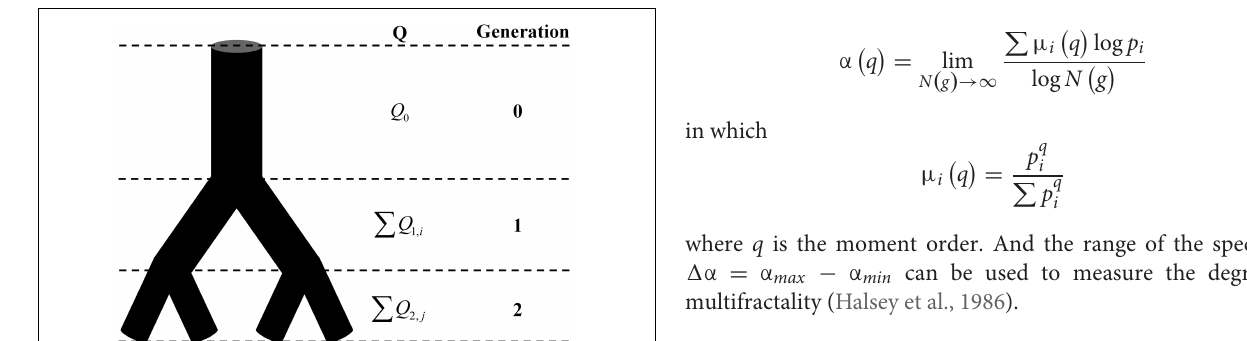
requires the image to be covered by non-overlapping boxes.